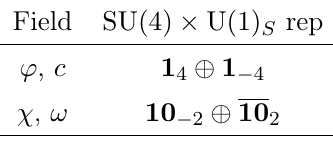
Table 4. The scalar truncation of the maximal supergravity in five dimensions relevant for holo- graphic dual to N = 1